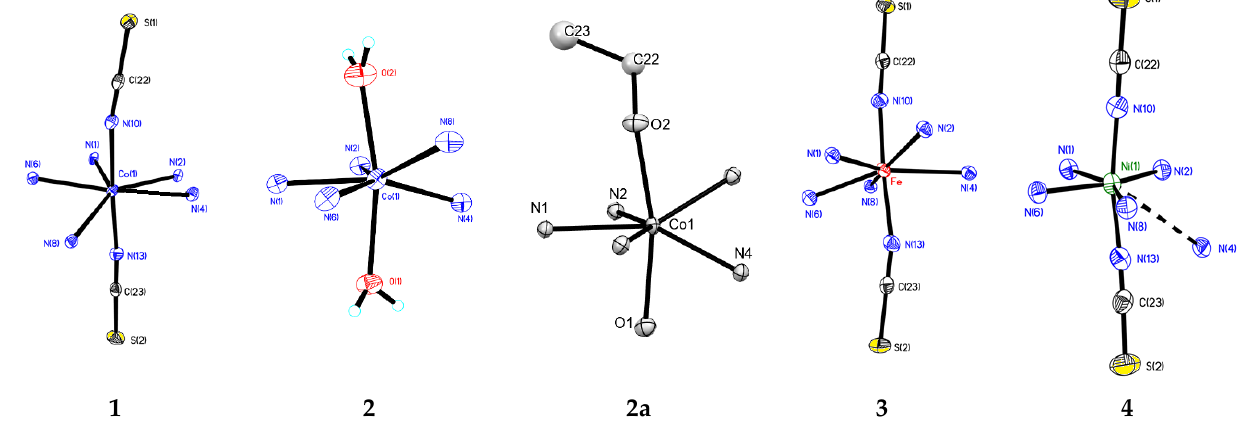
Figure 7. Coordination polyhedra in compounds 1 – 4 .